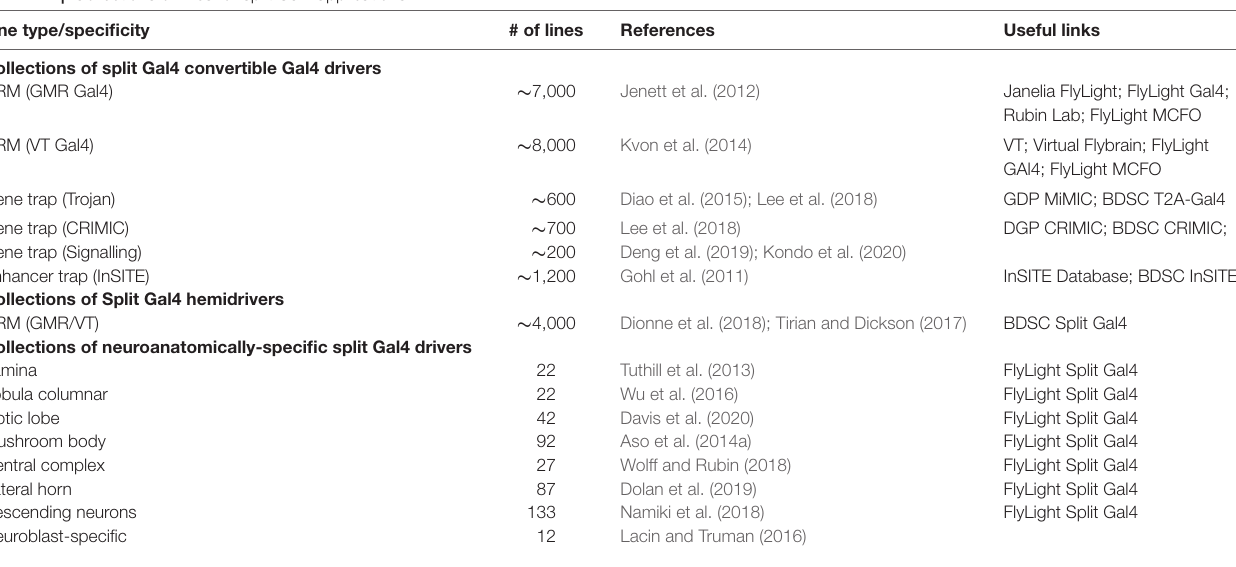
TABLE 1 | Collections of lines for split Gal4